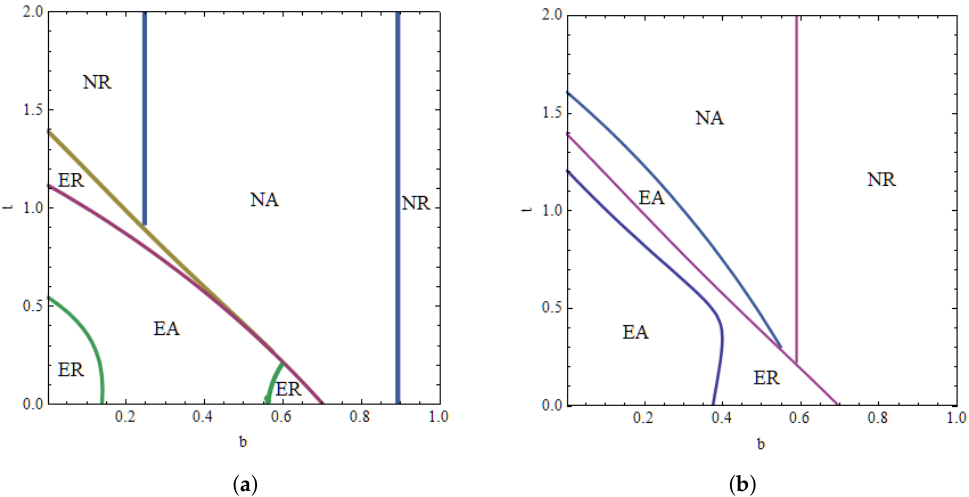
Figure 5. The equilibrium outcomes ( a = 0.5, c = 0.1). ( a ) r = 0.2. ( b ) r =